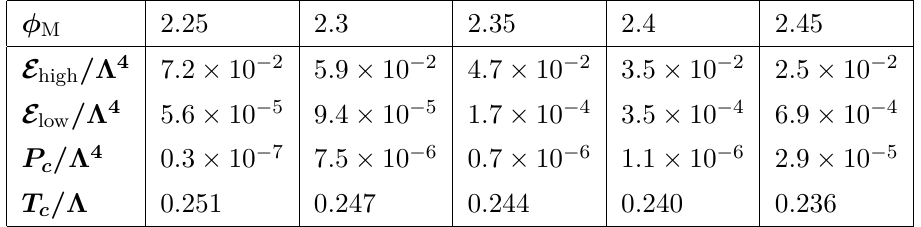
Table 1 . Local energy densities for the stable cold and hot phases of each theory and the corre- sponding transition pressures and